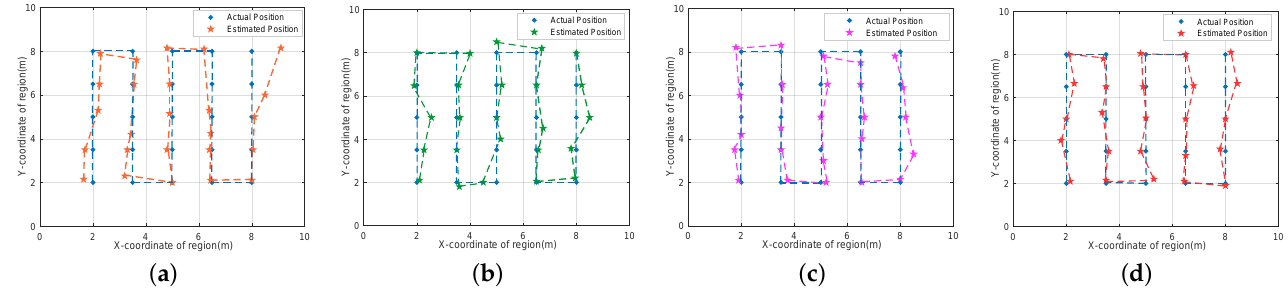
Figure 9. Positioning trajectory diagram of different methods: ( a ) Horus; ( b ) Radar; ( c ) Tilej; ( d )